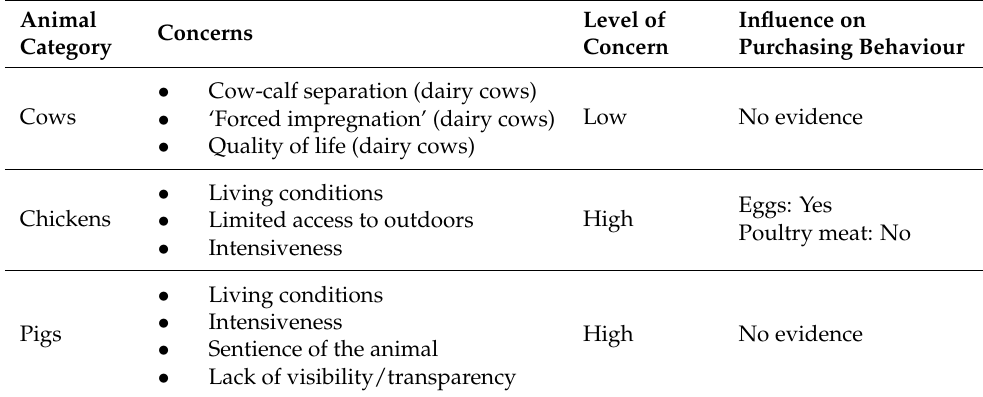
Table 6. Sector-specific perceptions of farm animal welfare identified through consumer focus groups in the Republic of Ireland ( n = 25) and Northern Ireland ( n =